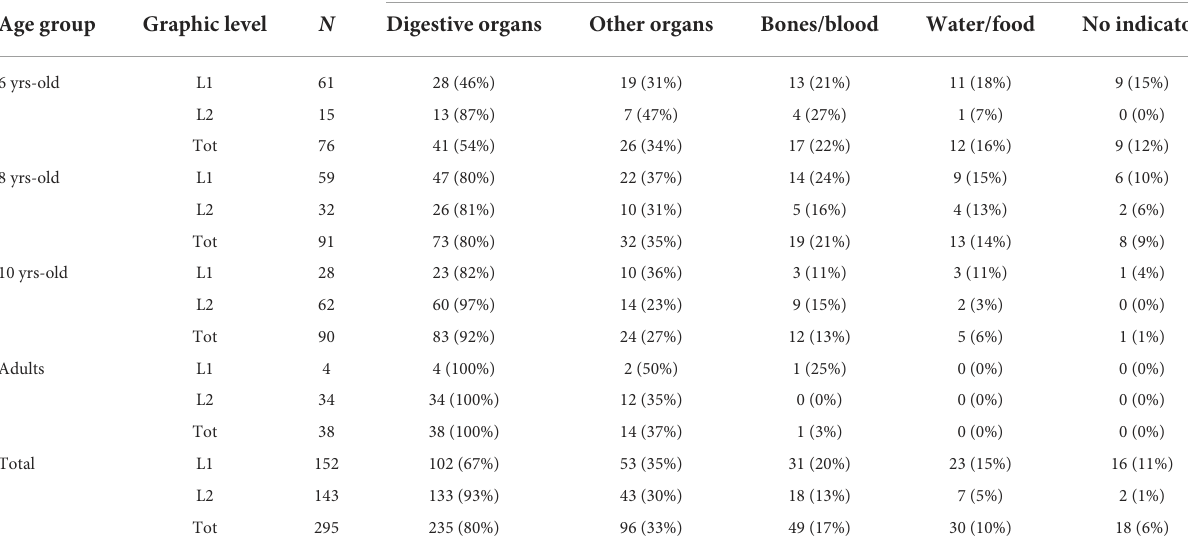
TABLE 2 Number (and percentage) of belly drawings depicting each type of graphic indicator as a function of age and graphic level (L1 = low graphic level and L2 = high graphic